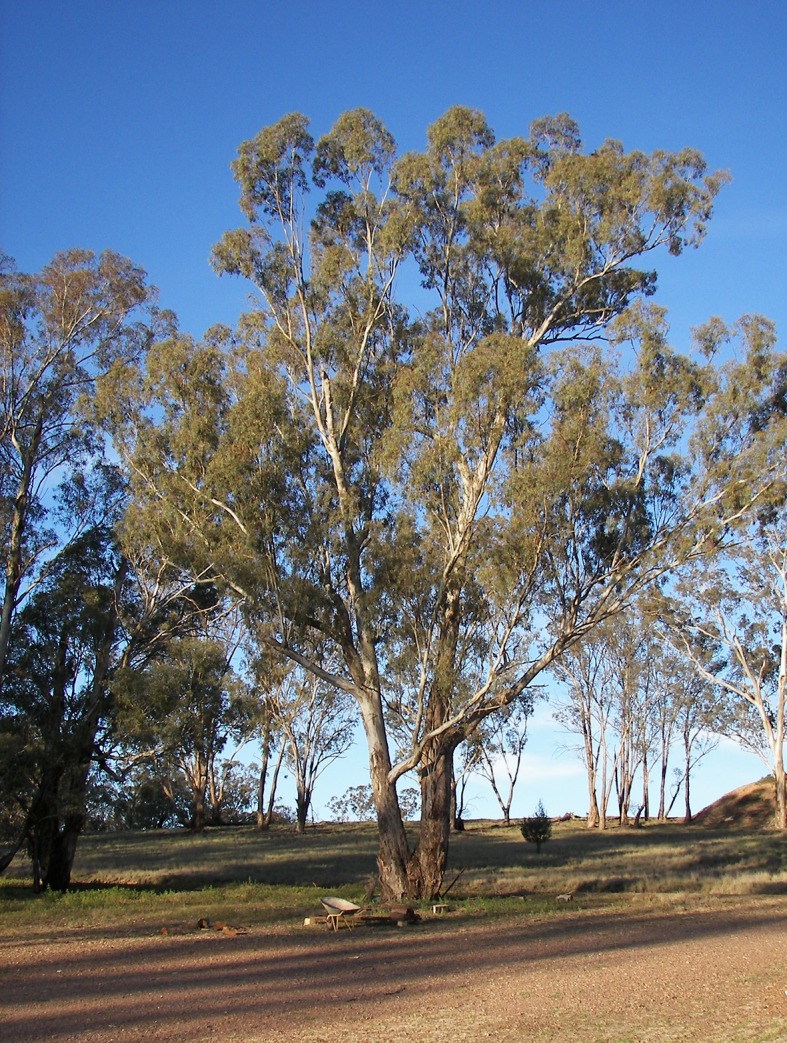

Eucalyptus tree.